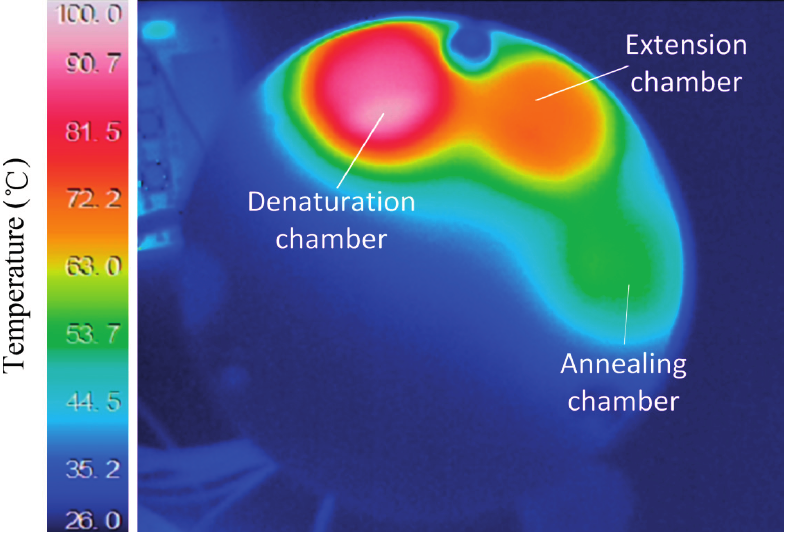
Figure 6. IR image of temperature fields in the three PCR